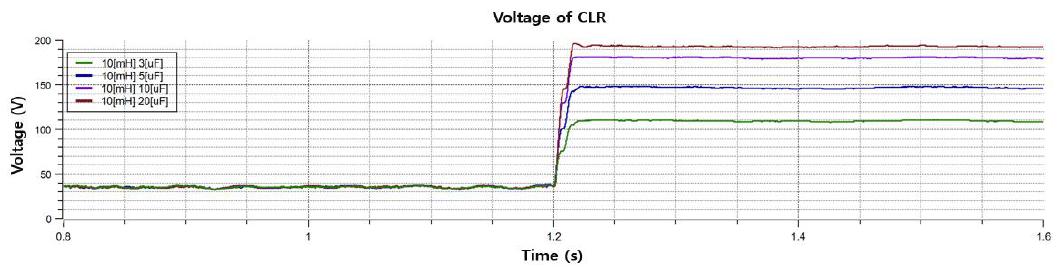
Figure 14. GPT zero-phase voltage (according to capacitor capacity).